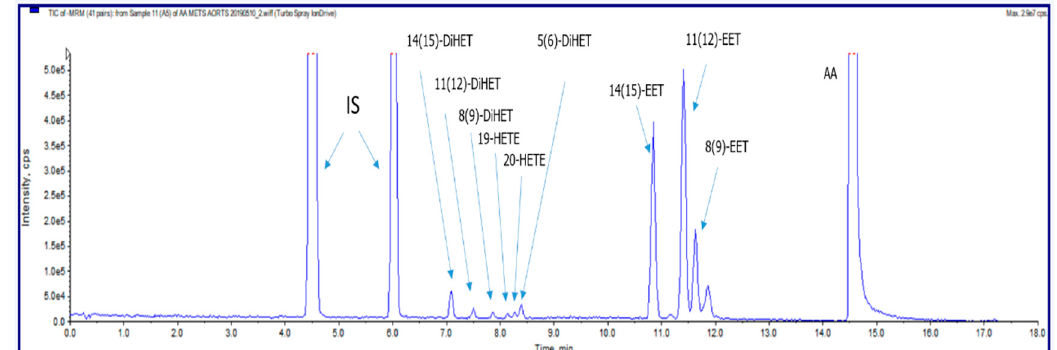
Figure 6. Representative liquid chromatography-tandem mass spectrometry chromatograms illustrating the profile of epoxyeicosatrienoic acid (EET) and HETEs formed by rat cerebral arteries, obtained under described experimental conditions.